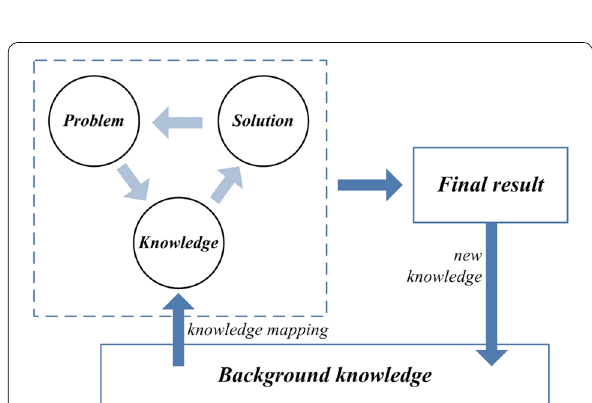
Figure 5 Problem-knowledge-solution co-evolution based